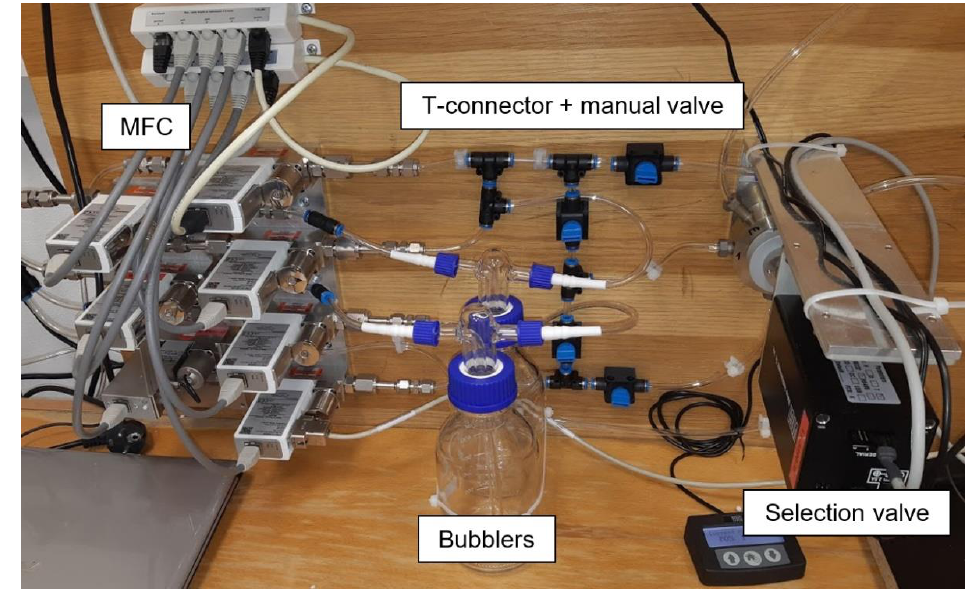
Figure 2. Photo of experimental setup for gas sensor testing.